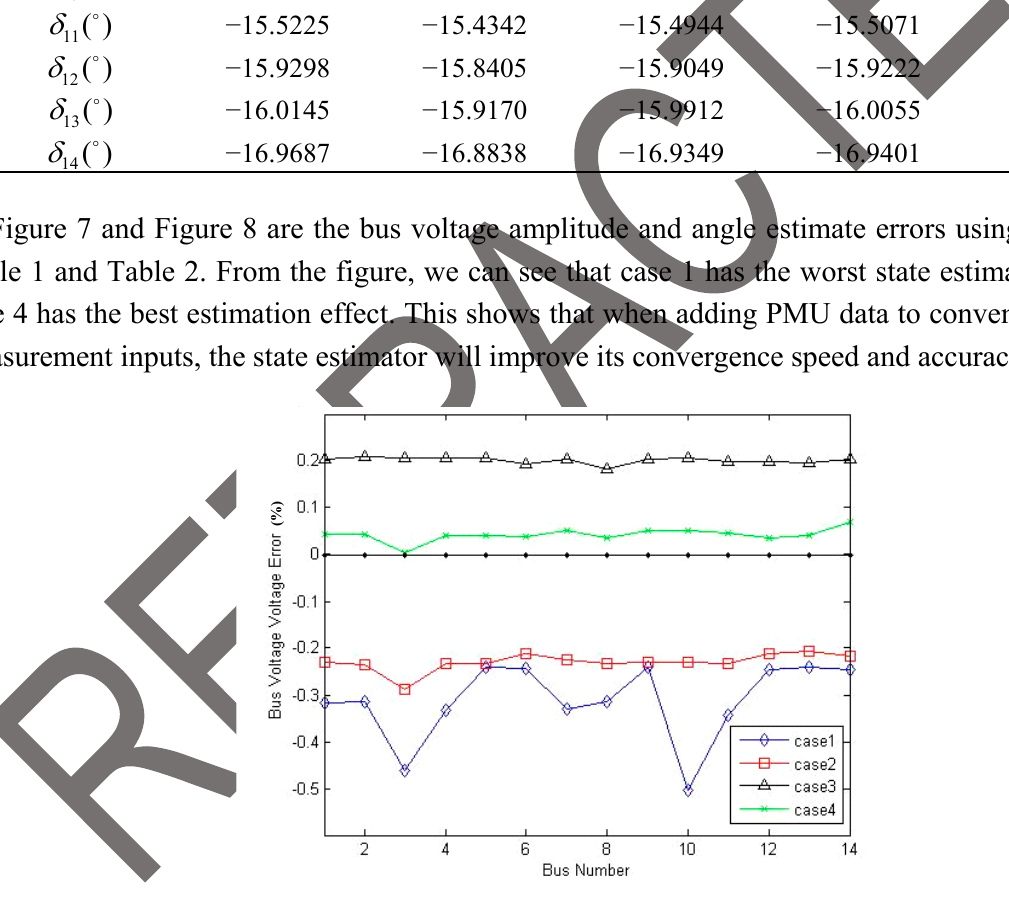
Figure 7. Bus voltage amplitude estimate error of simulation